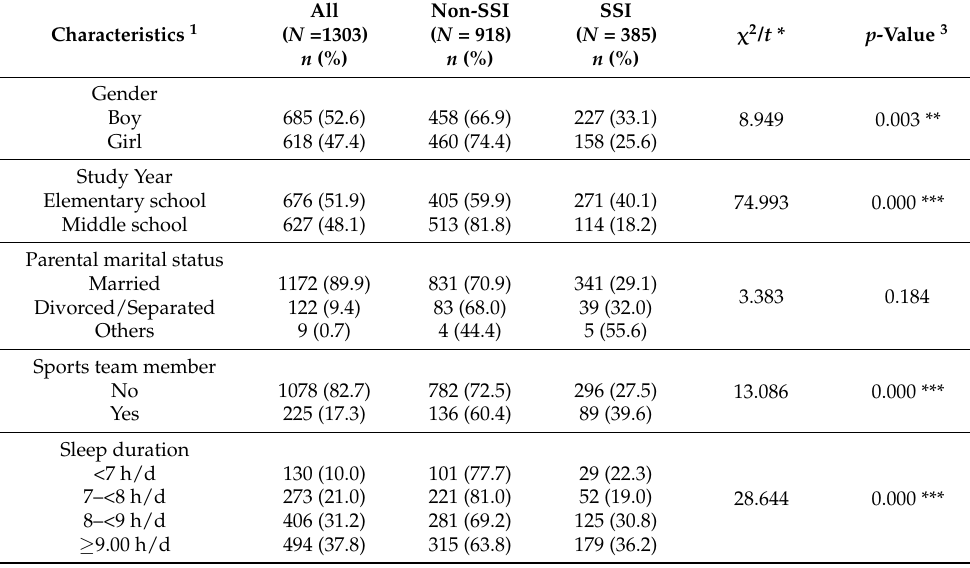
Table 2. Socio-demographic characteristics and other factors as a function of school sports injury (SSI)